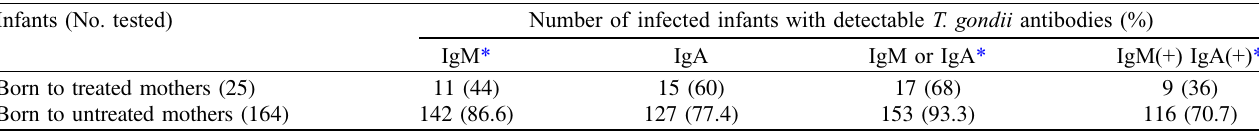
Table 3. IgM ISAGA and IgA ELISA Toxoplasma antibody test results in infants with congenital toxoplasmosis in the United States. Infants (No.